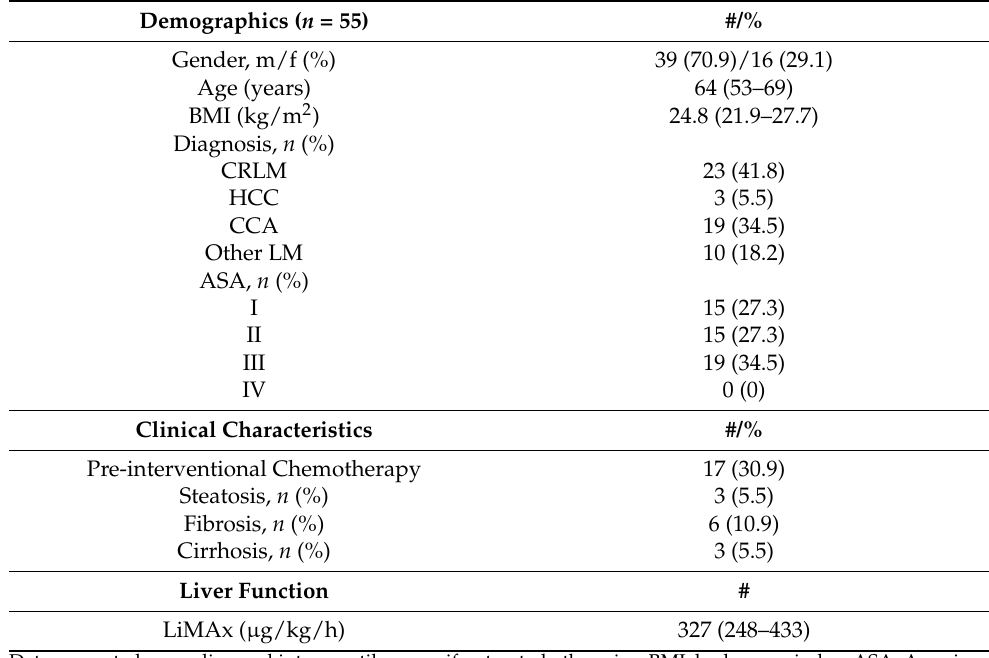
Figure 3. Linear regression analysis revealed a strong correlation between predicted and observed values, with an R 2 of 0.89. A score test using Spearman correlation showed a coefficient of 0.723 (CI: 0.536–0.924) and confirmed the observed strong correlation. Table 2. Clinical characteristics of the LiMAx subgroup. Table 2. Clinical characteristics of the LiMAx subgroup.